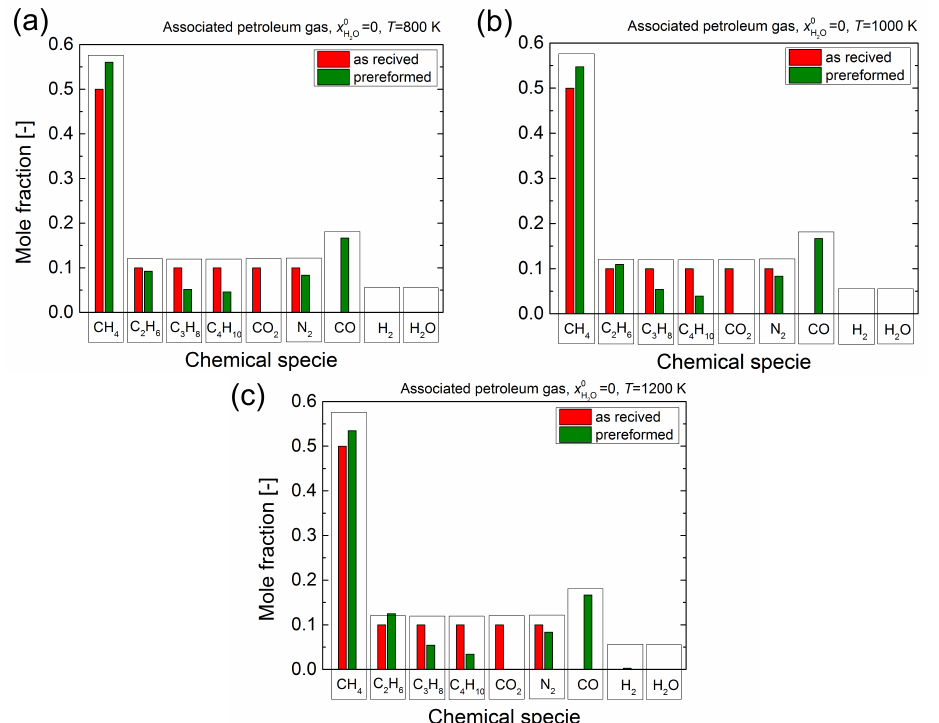
Figure 4. Thermodynamic possibility of pre-reforming of associated petroleum gas ( a ) T = 800 K, ( b ) T = 1000 K and ( c ) T = 1200